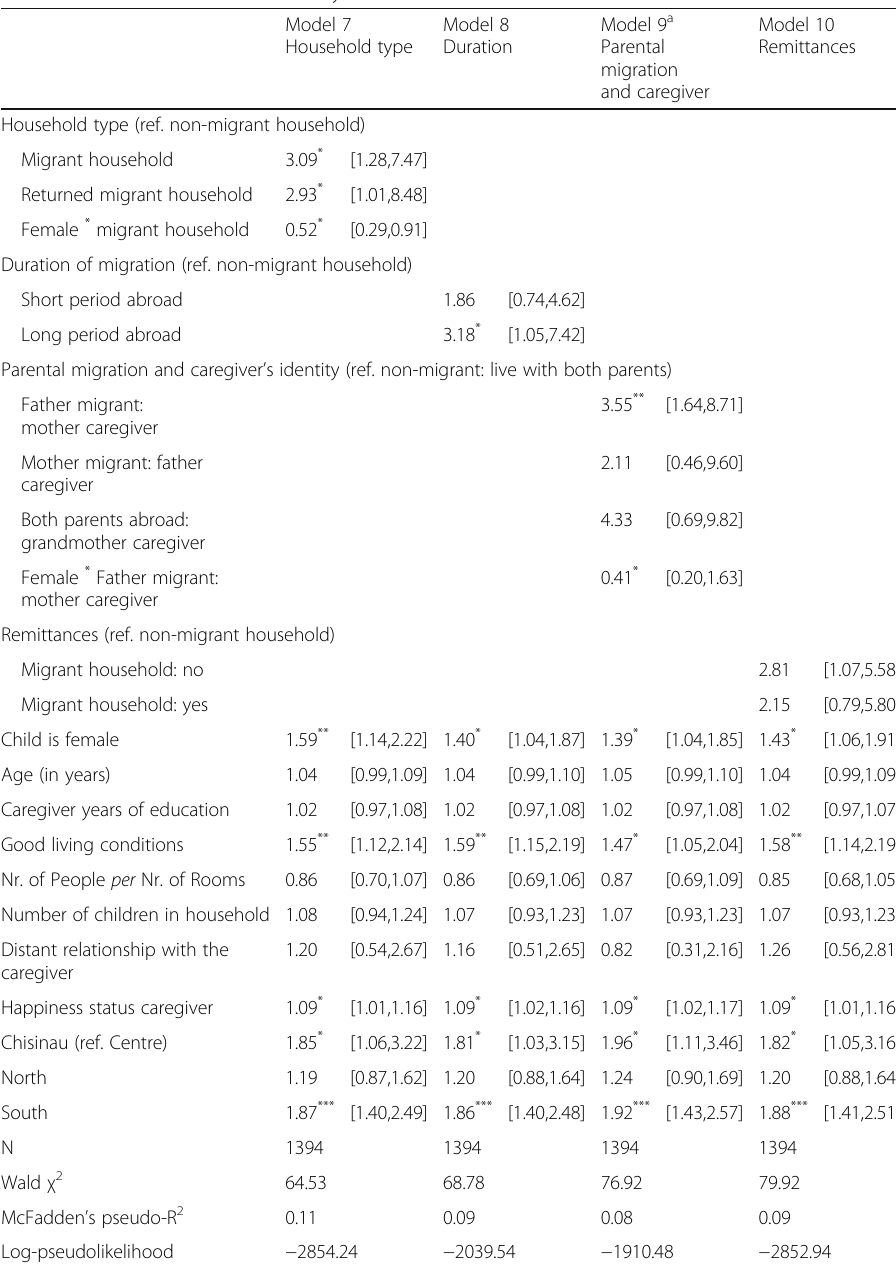
Table 3 Different transnational family characteristics and children ’ s health: